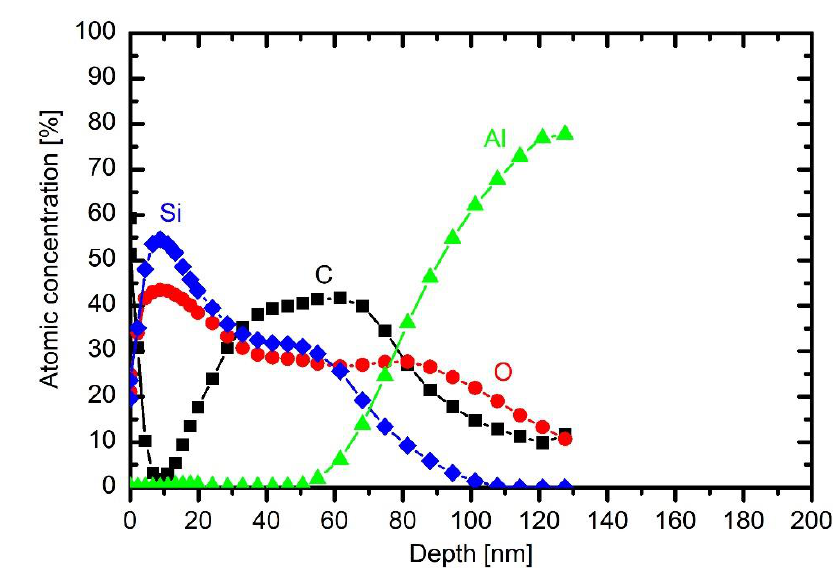
Figure 13. XPS depth profile of a sample exposed to plasma of HMDSO at 10 Pa for 30 s and 750 W.